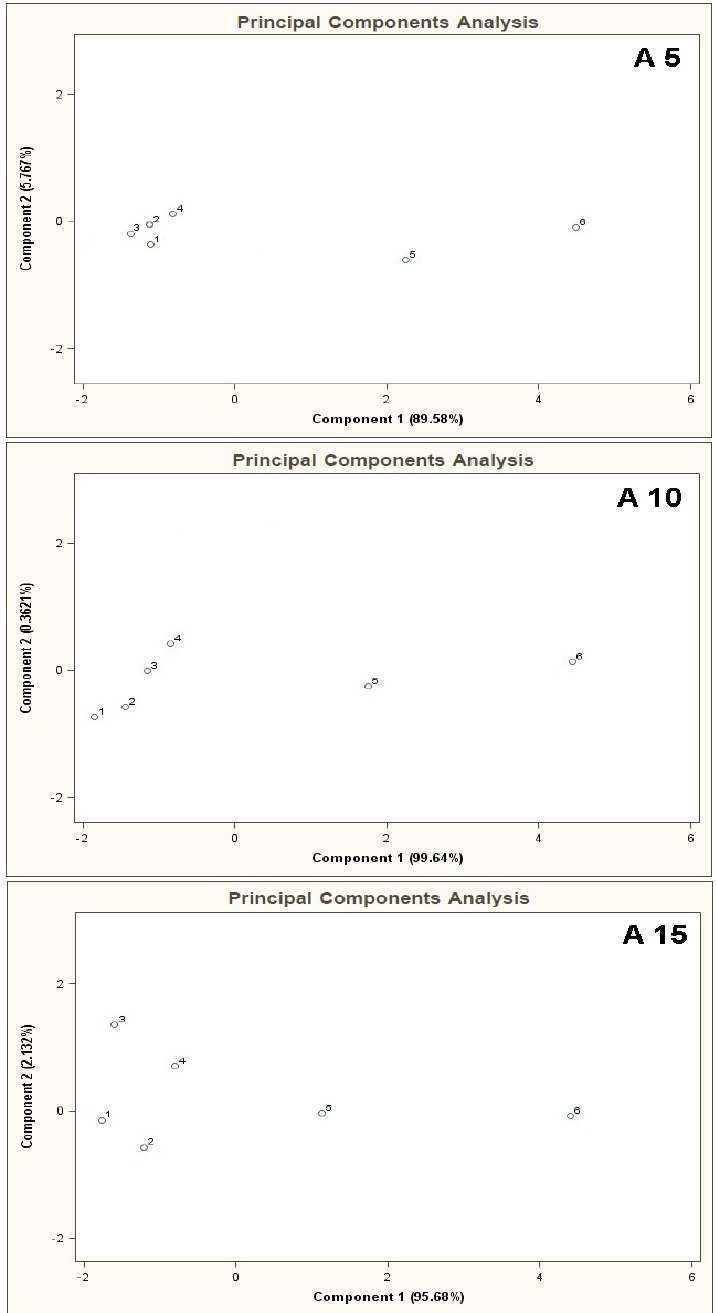
Figure 7. Result of PCA for the mixtures of type A 5 , A 10 , A 15 , where A 5, A 10, A 15 are the aqueous solutions of the basic components of amount 5, 10 and 15 in the mixtures of concentration 10 ppb v/v for each component. 1–6 are the mixtures of reference substances with the COPD markers of the respective concentrations: 0 ppb, 5 ppb, 10